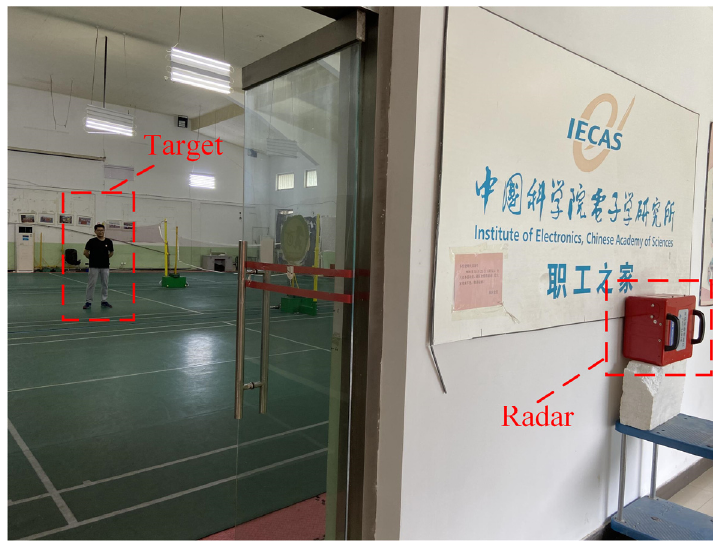
Figure 10. The realistic through − wall detection scenario.